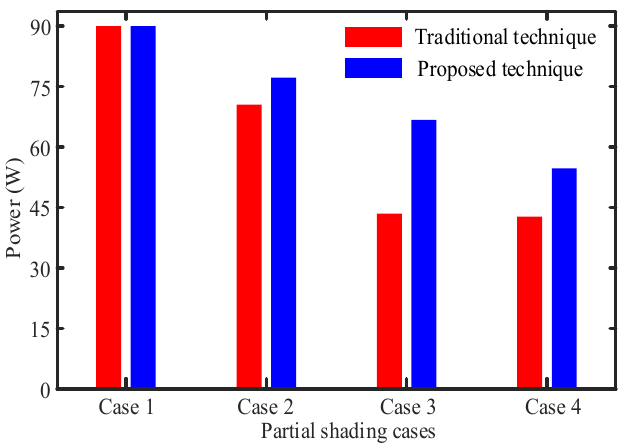
Figure 10. Output power for traditional bypass diode and proposed DPP technique for various mismatch cases or solar irradiance profiles shown in Table 2.